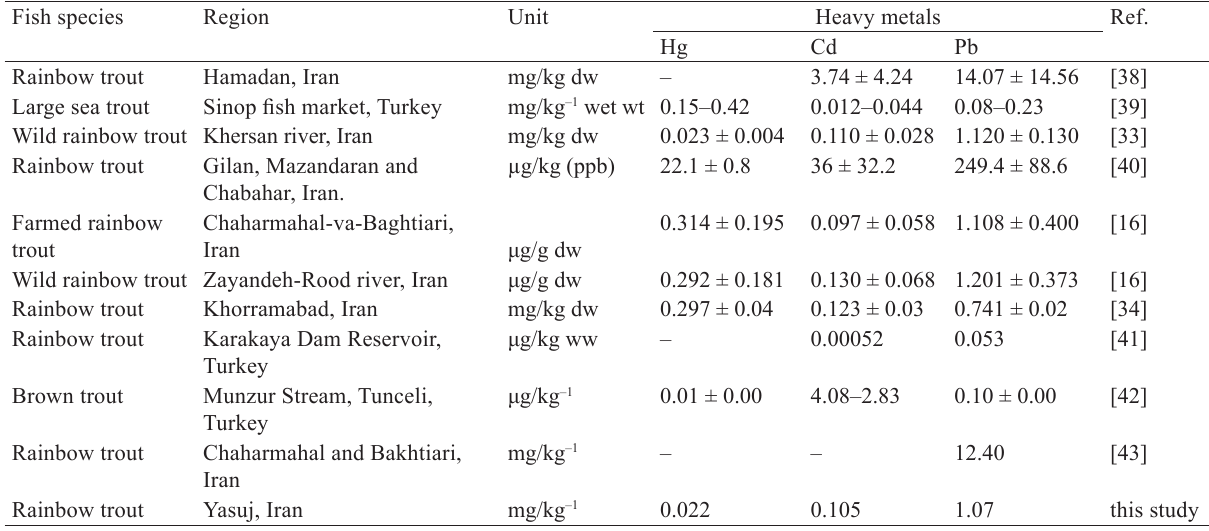
Table 2 Heavy metal levels in edible tissue of rainbow trout from different locations according to literature data: mercury (Hg), cadmium (Cd), lead (Pb)